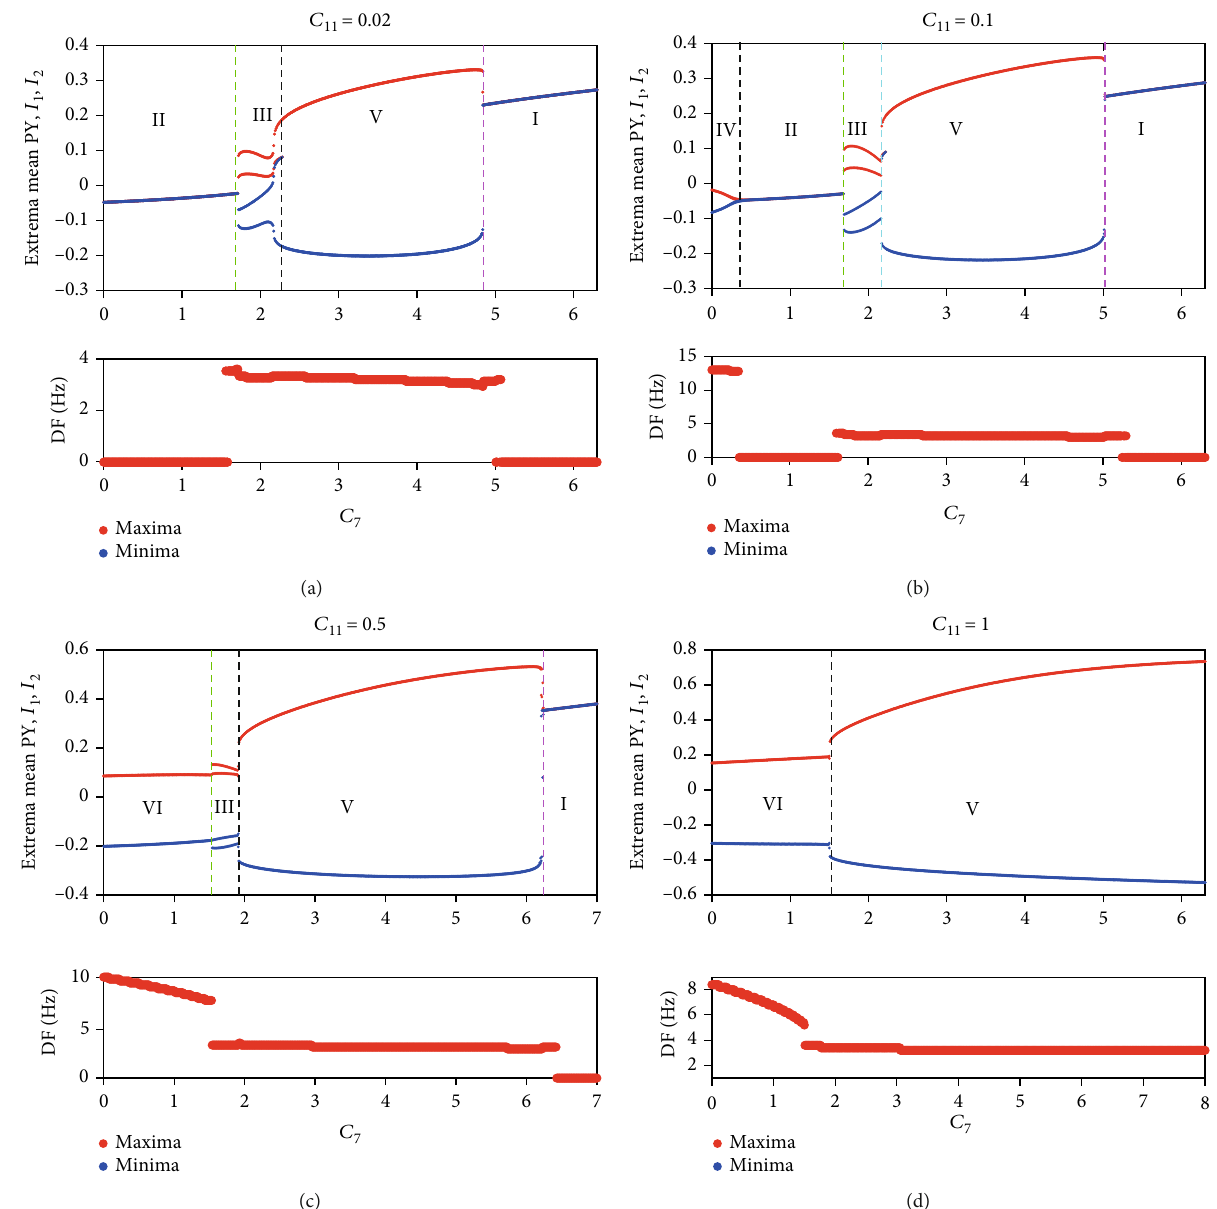
Figure 2: The bifurcation diagram (upper panels) and their corresponding dominant frequencies (lower panels) induced by C C 11 is set to 0.02 (a), 0.1 (b), 0.5 (c), and 1 (d), respectively. Six fi ring modes can be observed such as I (high saturated state), II (low saturated state), III (SWD), IV (tonic), V (low-frequency clonic), and VI (high-frequency clonic). The dominant frequencies of states I and II are 0 Hz, of states III and V are between 2 Hz and 4Hz, and of state VI are between 5Hz and 10 Hz, and the dominant frequencies of state IV are up to 13